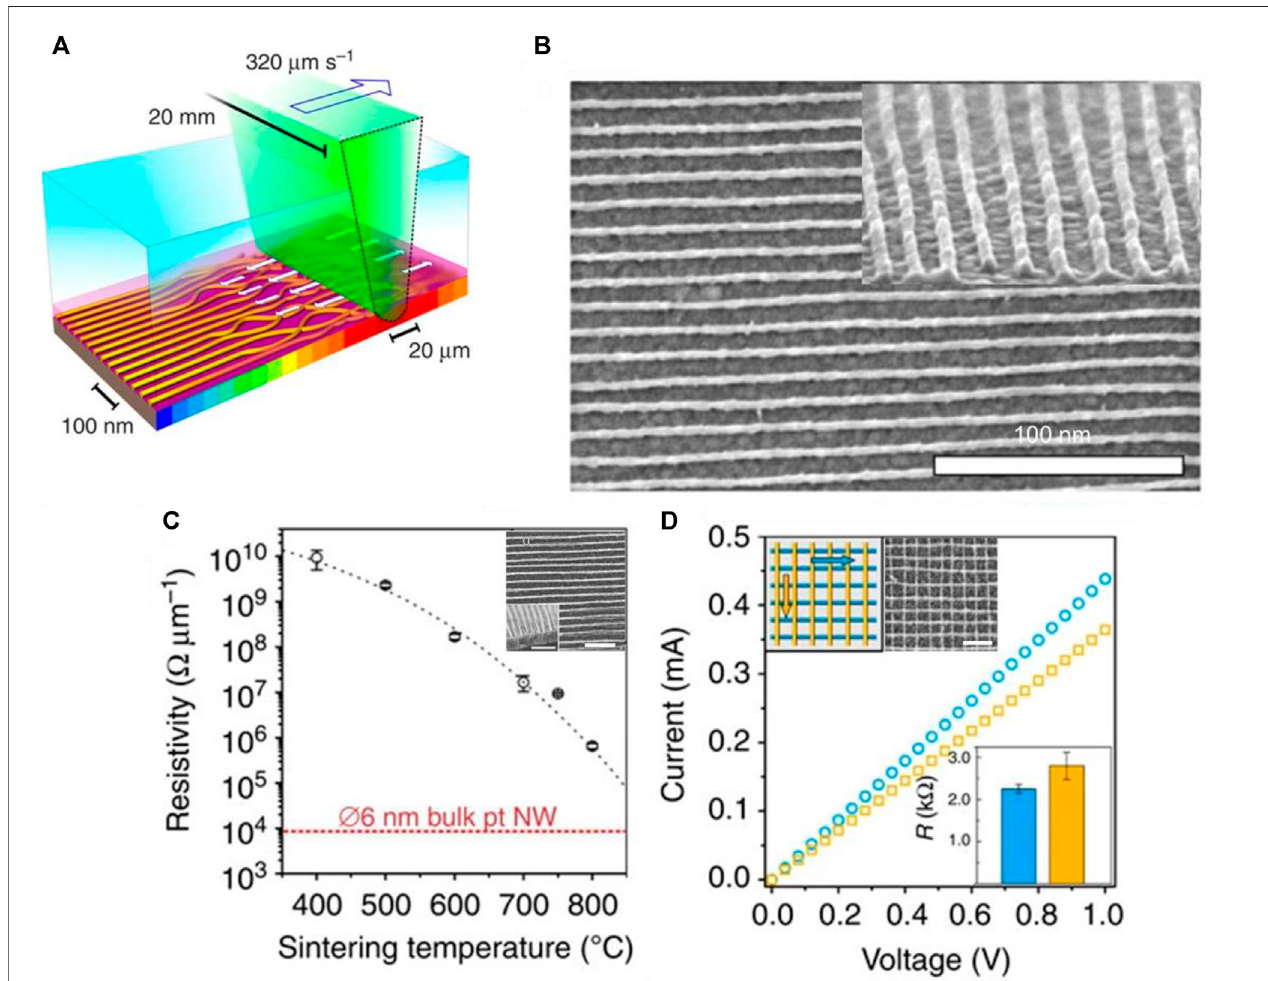
FIGURE 9 | (A) Schematic representation of the laser zone annealing for shear alignment of BCP thin fi lms; (B) SEM micrograph showing the top-view (and inset showing cross-sectional view) of Pt nanowires (soak time: 1 h, precursor: 0.02M Na 2 PtCl 4 in 0.5M HCl) produced after polymer ashing; (C) Electrical resistivity (resistance per unit length ofthe wire) measured at room temperature as a function of sintering temperature (5 min in 5% H 2 in Ar). At 800 ° C, resistivity approaches bulk Pt (dashed red line) with inset SEM micrograph of single layer aligned Pt nanowires; (D) I – V characteristics of the square grid; electrical properties are nearly isotropic. Error bars represent standard deviation. for atleast8 devices. Reproduced with permission from ref (Majewski et al., 2015).